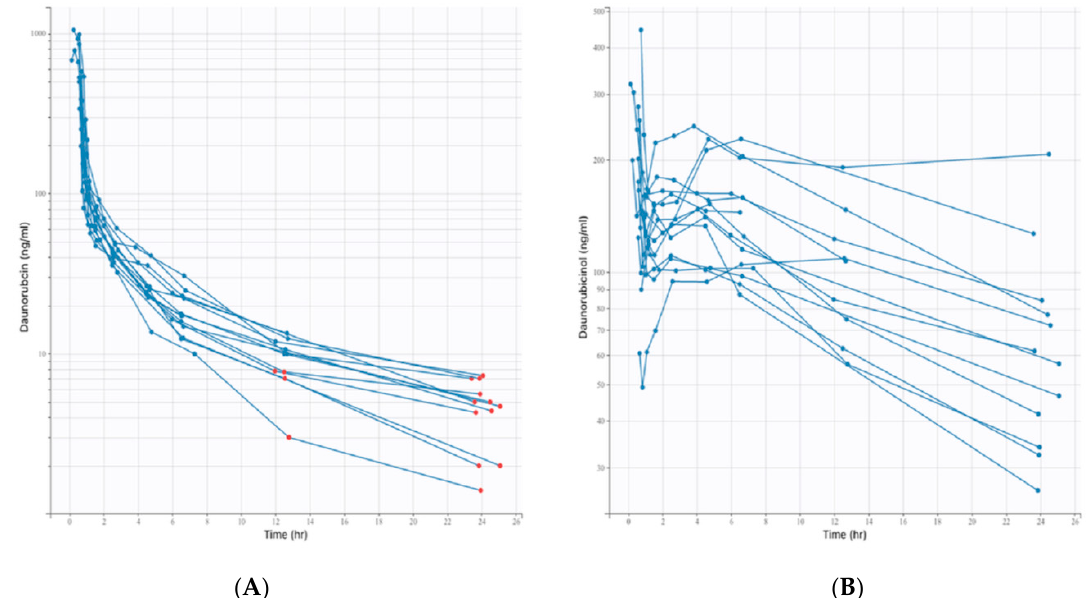
Figure 1. Semi-logarithmic spaghetti plots of individual PK profiles of daunorubicin ( A ) and daunorubicinol ( B ) plasma concentrations. Red dots are censored data (<LLOQ).